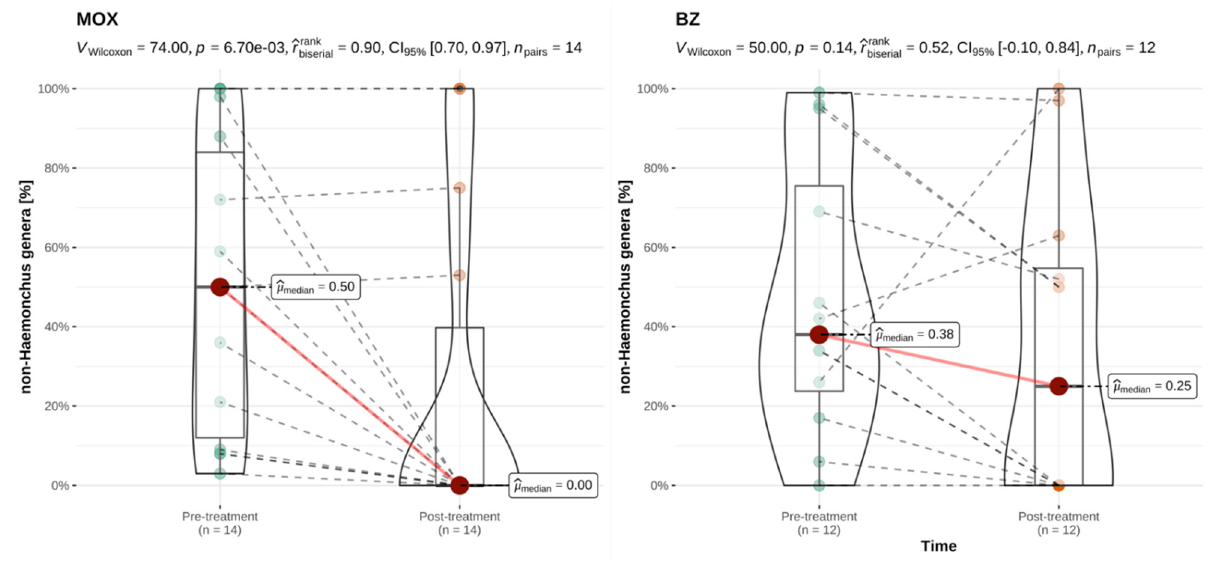
Figure 6. Paired comparison of the pre- and post-treatment percentage of non- Haemonchus strongyle